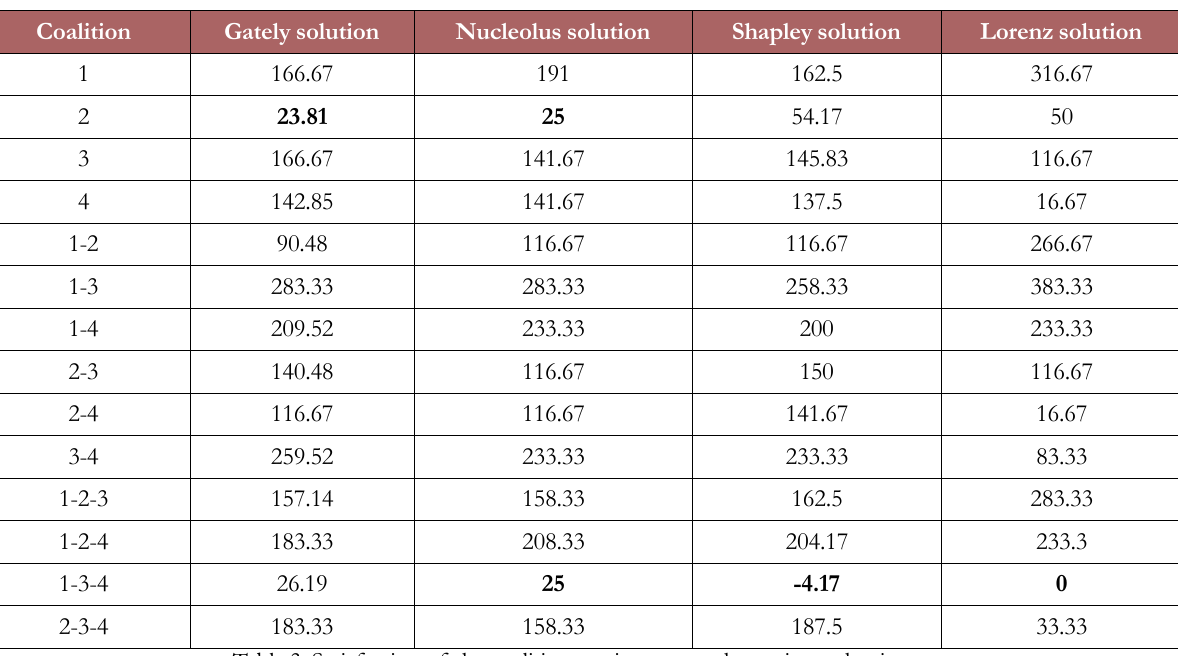
Table 3. Satisfaction of the coalitions various game-theoretic mechanisms